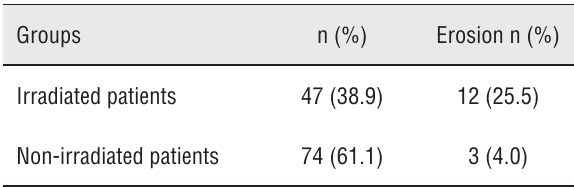
Table 2 - urethral erosion after As placement at our institution from May 2001 to January 2016 in irradiated and non-irradiated